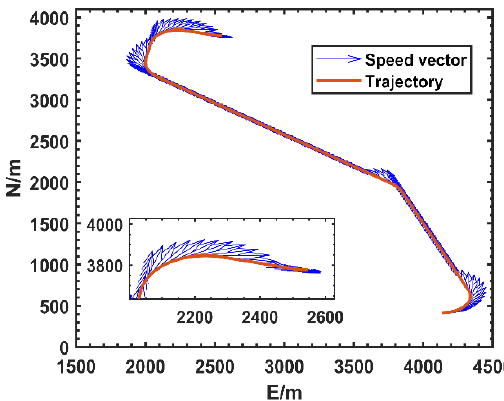
Figure 13. Planned trajectory with proposed scheme.